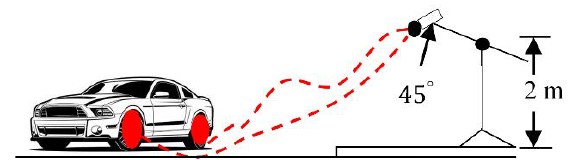
Figure 2. Measurement principle.